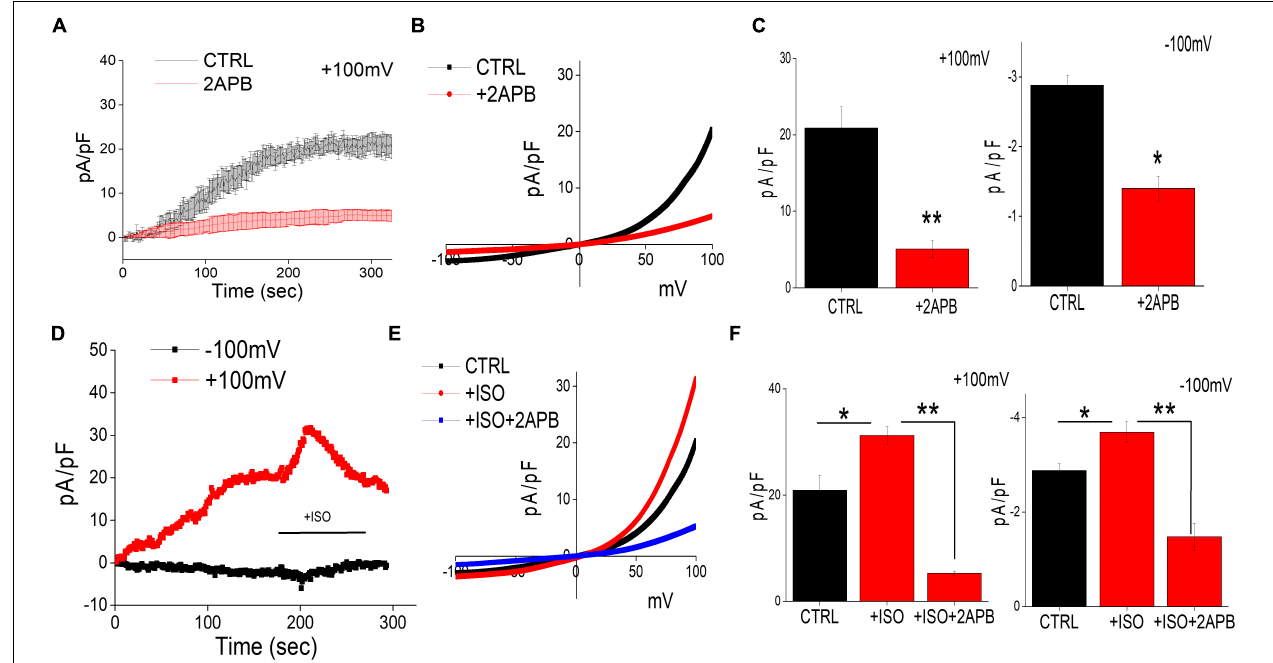
FIGURE 2 | Isoproterenol-Induces TRPM7 activation in neuroblastoma cells: (A) Representative trace showing whole cell recording (outward currents) in control cells and cells pretreated with 2APB (100 µ M). The external solution used was normal SES solution that had 1 mM Ca 2 + and Mg 2 + respectively was used to obtain the currents (outward/inward) at +100 mV/–100 mV in differentiated SH-SY5Y cells. (B) IV curves under these conditions (control and bath pre application of 100 µ M 2APB) as labeled in the figure were obtained using peak currents. Quantitation of current density at ± 100 mV is shown in (C) . * Indicate significance ( p < 0.05) and ** Indicate significance ( p < 0.01). (D) Traces showing whole cell recording in control cells at ± 100 mV were recorded followed by stimulation with ISO (bath application of 20 µ M ISO, with and without pretreatment of 100 µ M 2APB) as labeled in the figure. IV curves shown are acquired when currents reach their peak in each condition and are shown in (E) Quantitation of current density at ± 100 mV is shown in (F) . The columns show the means ± SD of 6 experiments.